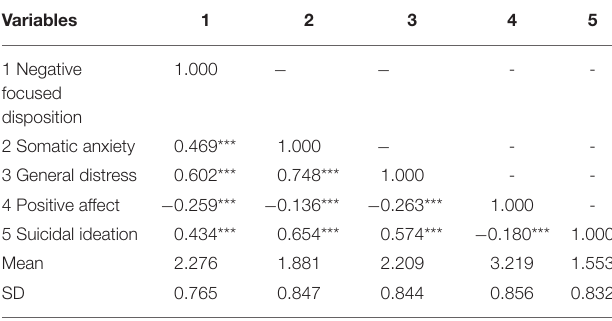
TABLE 2 | Descriptive statistics and correlation matrix for negative focused disposition, somatic anxiety, general distress, positive affect, and suicidal ideation.